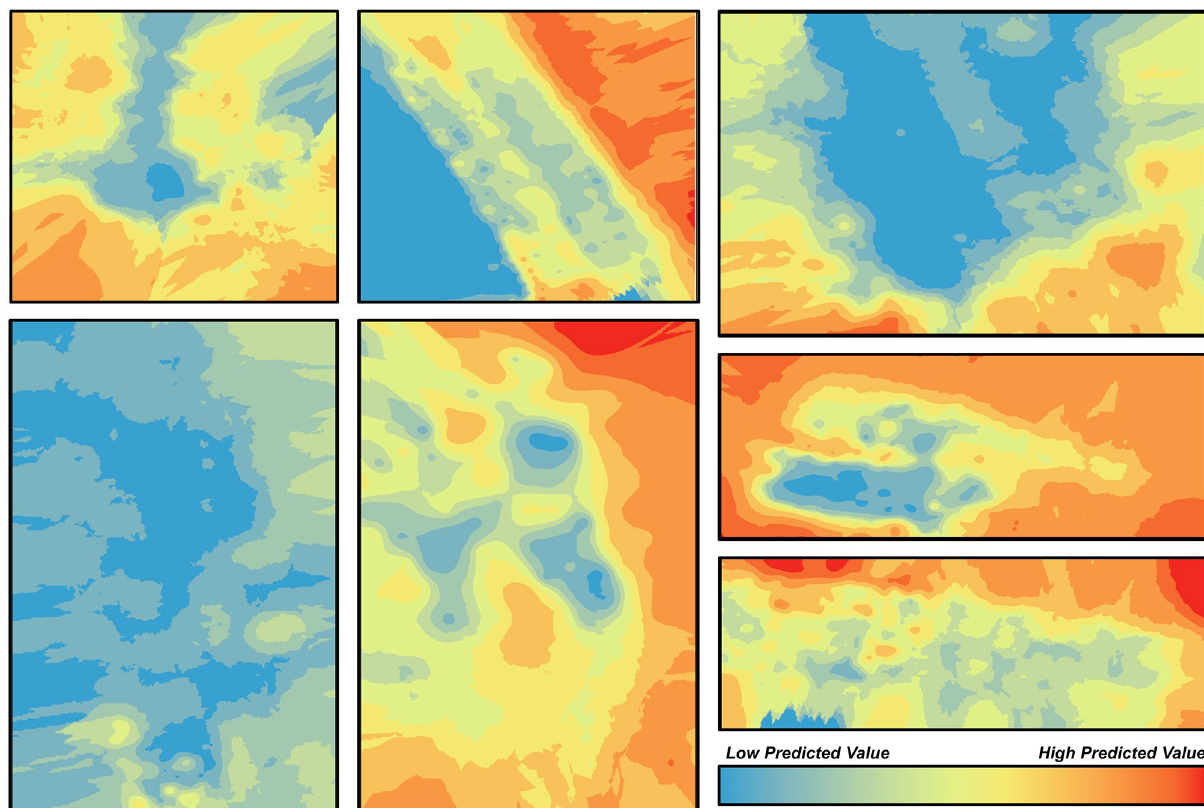
Figure 4. Empirical Bayesian Kriging (EBK) interpolation of adult spotted lanternfly (SLF) densities within vineyard blocks across 7 vineyards. Each square indicates a single vineyard block. Darker (red) colors indicate higher predicted density of SLF egg masses, whereas lighter colors (blue) indicate lower predicted